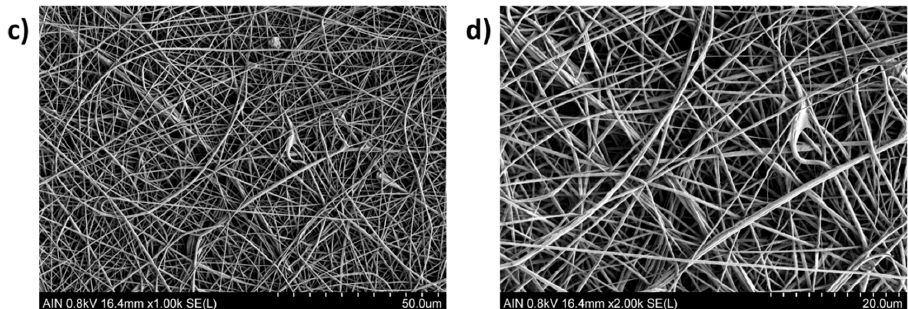
Figure 3. SEM images of the PS electrospun fibers ( a , b ) and PVC electrospun fibers ( c , d ) at different scale bar of 1000× and 2000×, respectively.